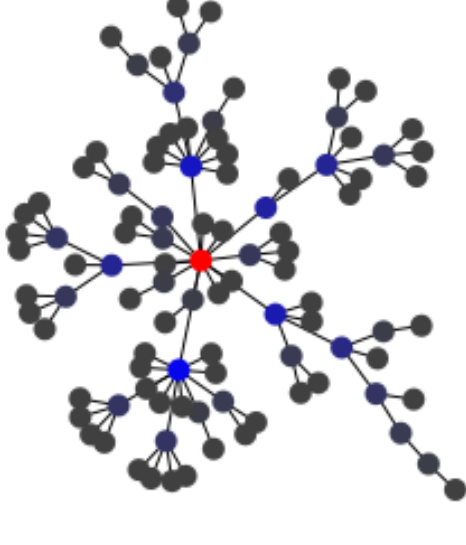
Figure 1. The Barabási–Albert